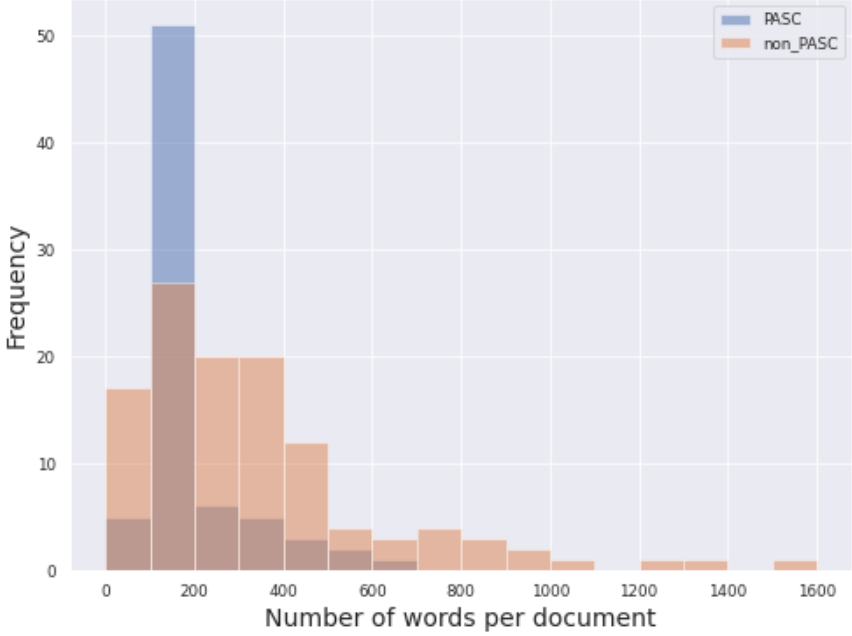
Figure 2. Histogram of words count per document and